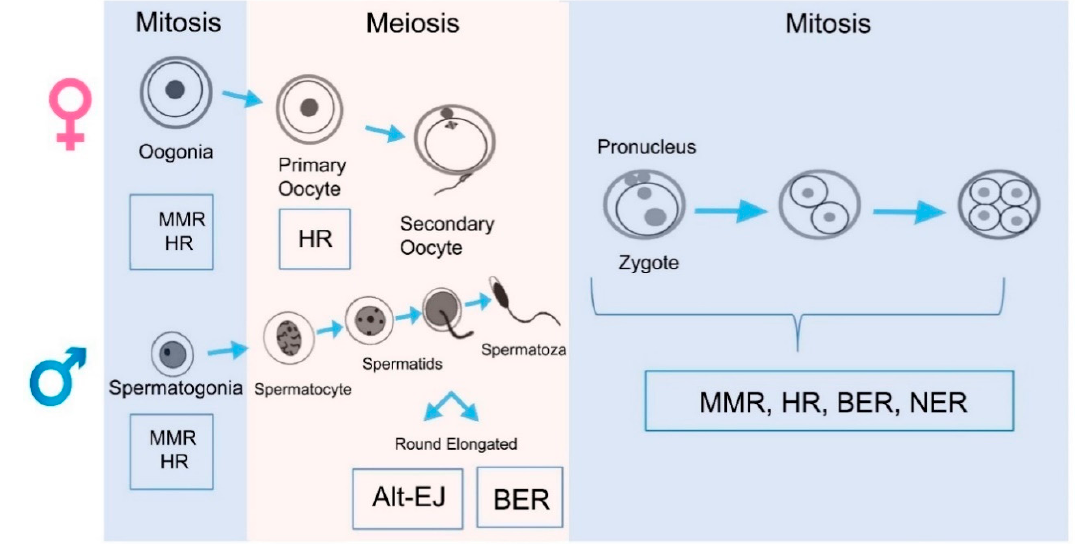
Figure 3. The primary DNA repair mechanisms occurring at the different stages of gamete and embryo production.